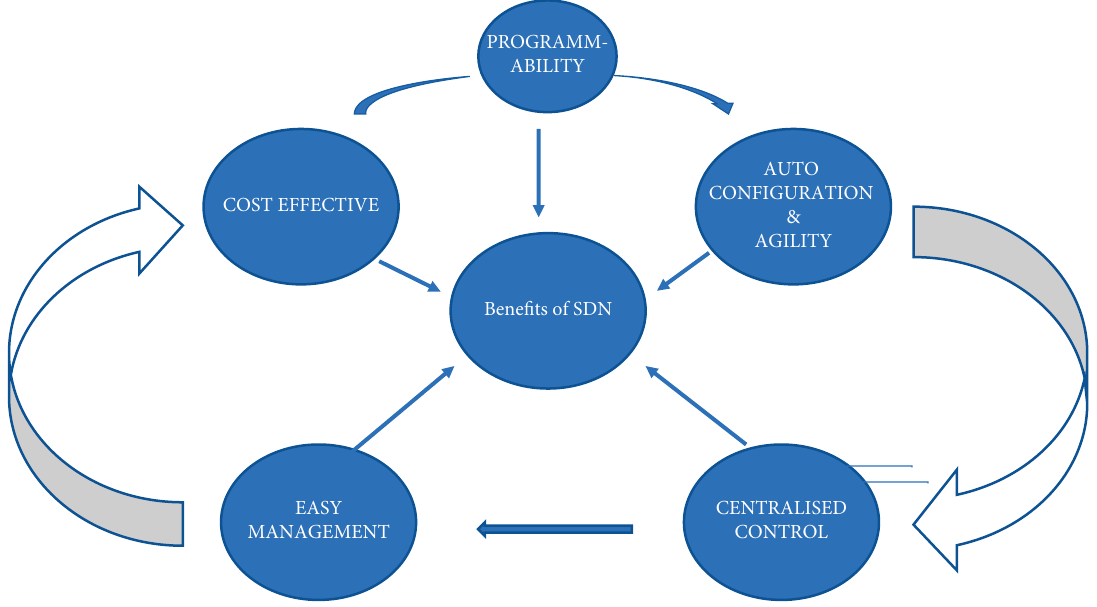
Figure 7: Benefits of